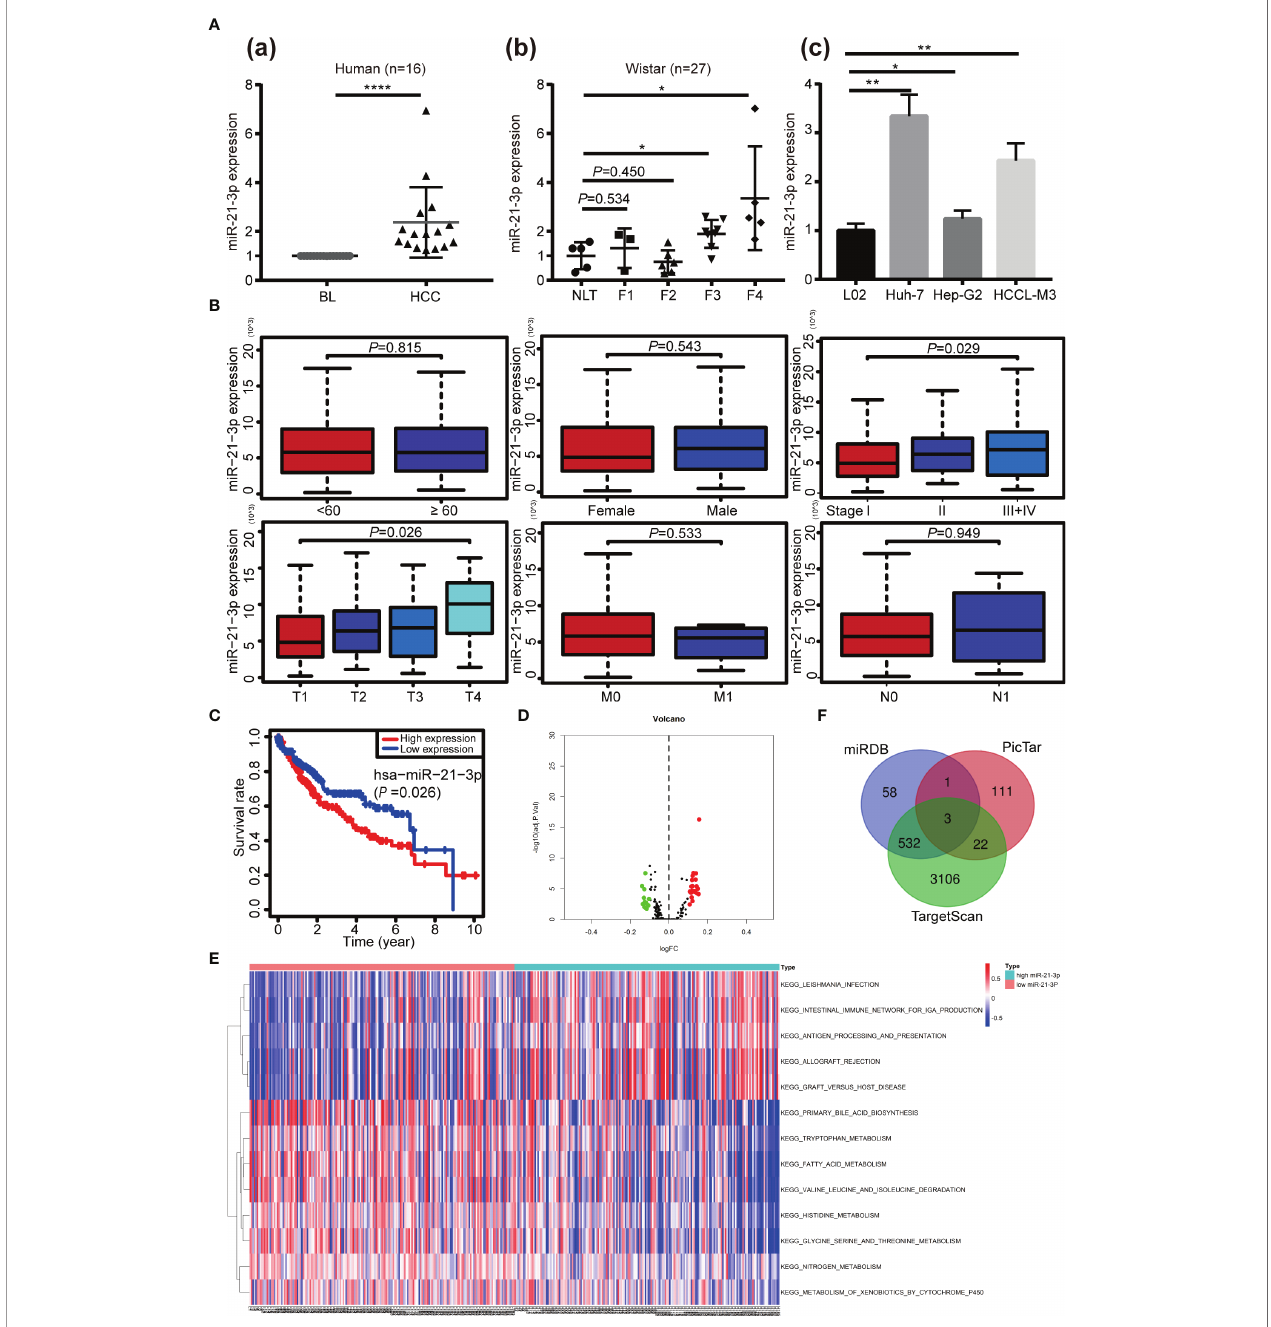
Figure 1 Upregulation and clinical signi fi cance of miR-21-3p in hepatocellular carcinoma (HCC). (A) TaqMan quantitative RT-PCR was performed to analyze microRNA-21-3p (miR-21-3p) expression; 16 pairs of human HCC and counterpart background liver (BL) tissue were examined (A -a ) ; Normal liver tissue (NLT), fi brotic (F1 – F3) and cirrhotic (F4) tissue from rat models were also analyzed (A -b ) ; MiR-21-3p expression in L02, Huh-7, Hep-G2 and HCCL-M3 cell lines (A -c ) ; Each dot indicates the level of expression in an individual case, calculated by the 2 − DD Ct method. (B) Association of the miR-21-3p expression level with clinicopathological characteristics (age, gender, and TNM staging, respectively). (C) Kaplan – Meier curves representing the relationship between miR-21-3p and the overall survival (OS, as percentage) in HCC patients among the studied data set from The Cancer Genome Atlas (TCGA) (n = 376). Statistical signi fi cance between miRNA expression and OS was determined using the log-rank test. (D) Volcano map of the microarray gene set variation analysis (GSVA) data based on high or low miR-21-3p expression. (E) Kyoto Encyclopedia of Genes and Genomes pathways of miR-21-3p, based on TCGA data GSVA in HCC. Signi fi cant terms are described in the heat map (top 13 listed). (F) Venn diagram of the intersections of three databases (miRDB, TargetScan, and PicTar) of predicted downstream target genes of miR-21-3p. *P < 0.05, **P < 0.01, ****P <